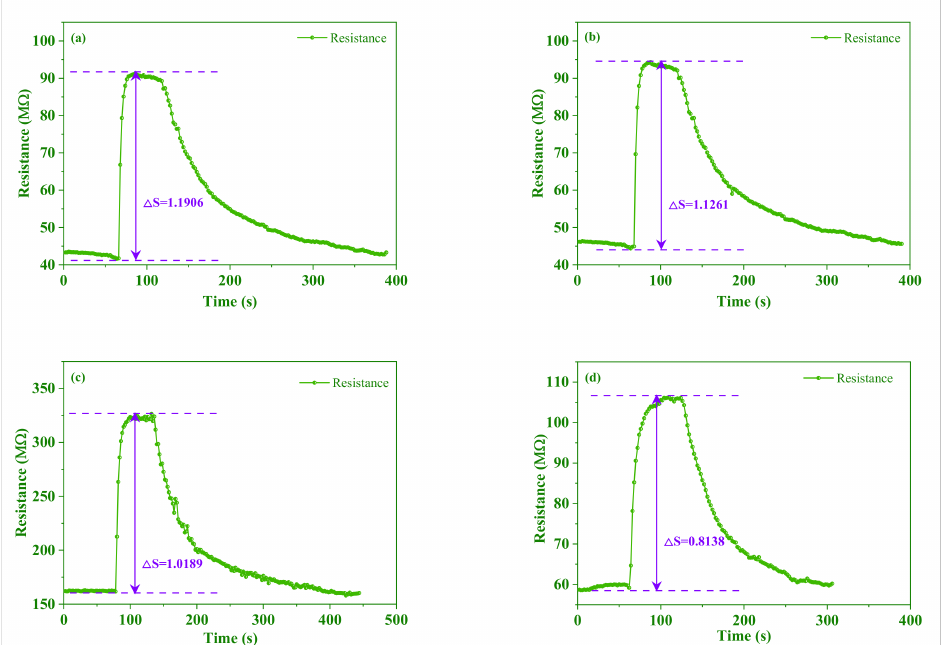
Figure 6. The sensing performance of PANI/AgNWs/silk sensors prepared with 1.5 mL AgNWs polymerizing 1.5 h to 100 µ g/L TMA for one month in ( a – d ).